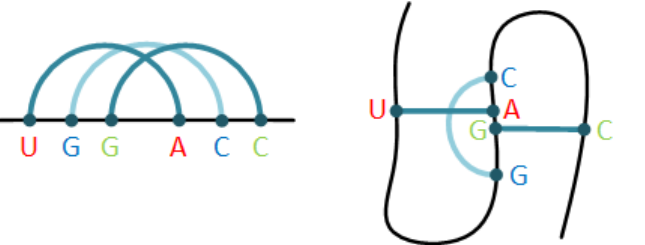
Figure 1. H-, K-, L-, and M-type pseudoknots.